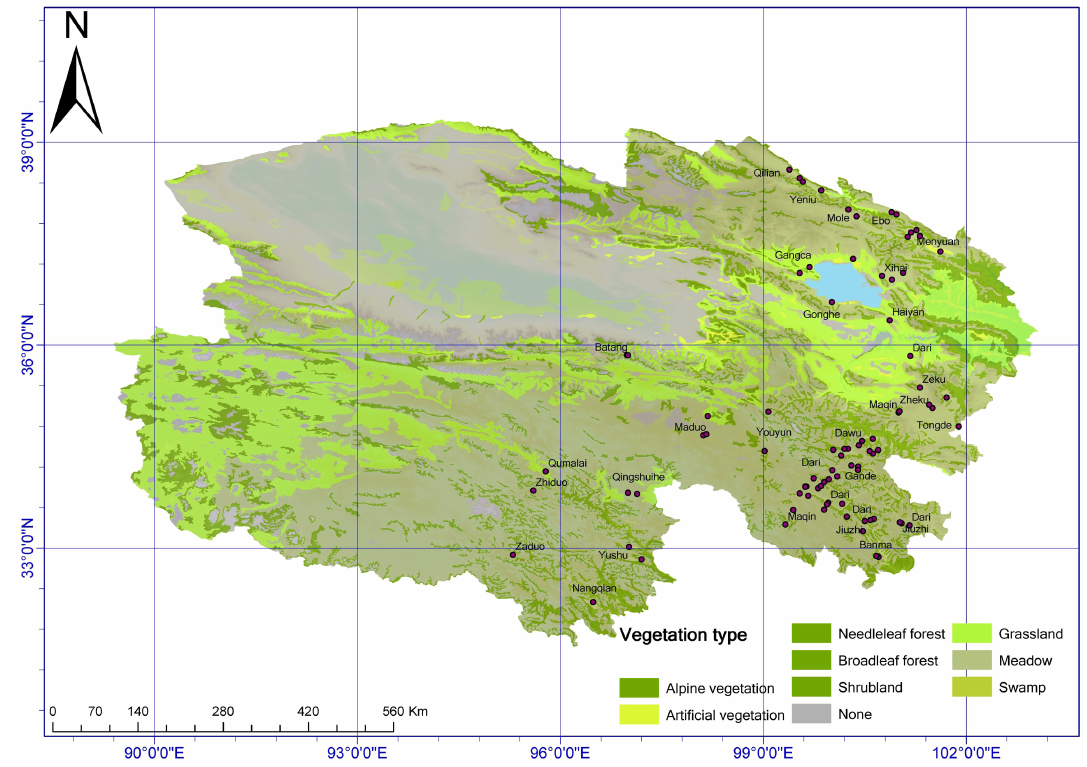
Figure 1. The locations of experimental